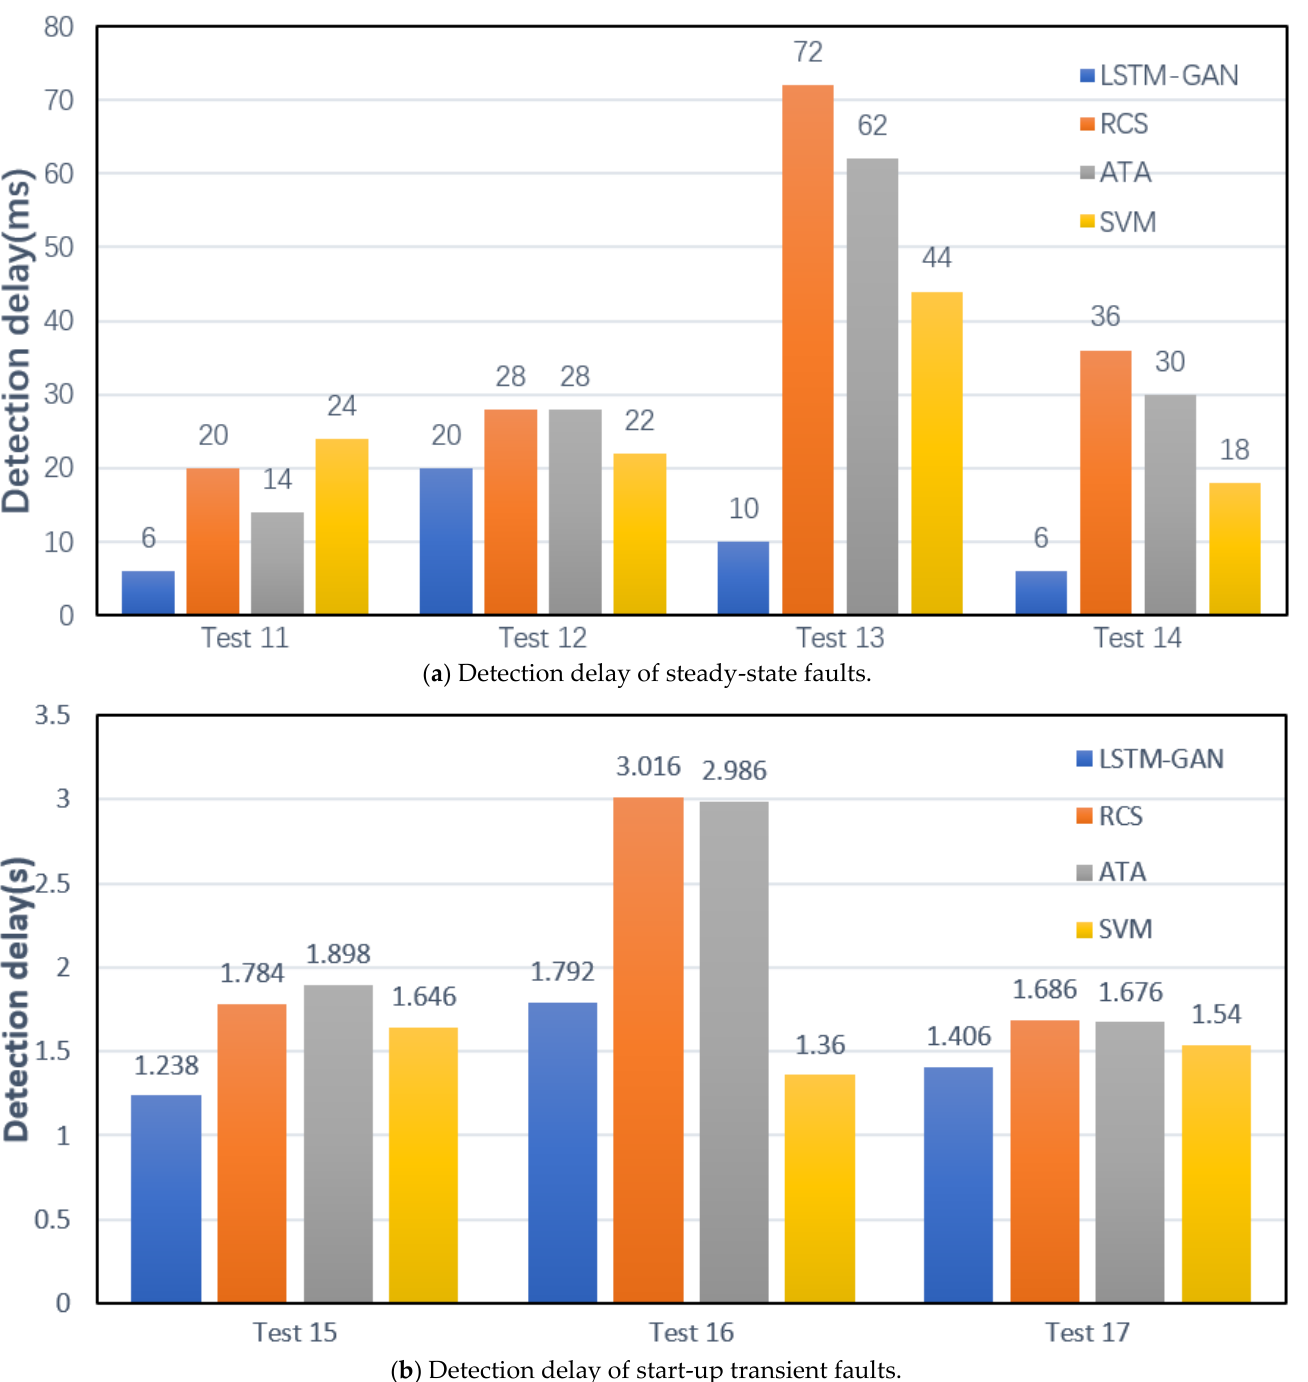
Figure 7. Comparison between LSTM-GAN having a sample size of 10 × 24 and other